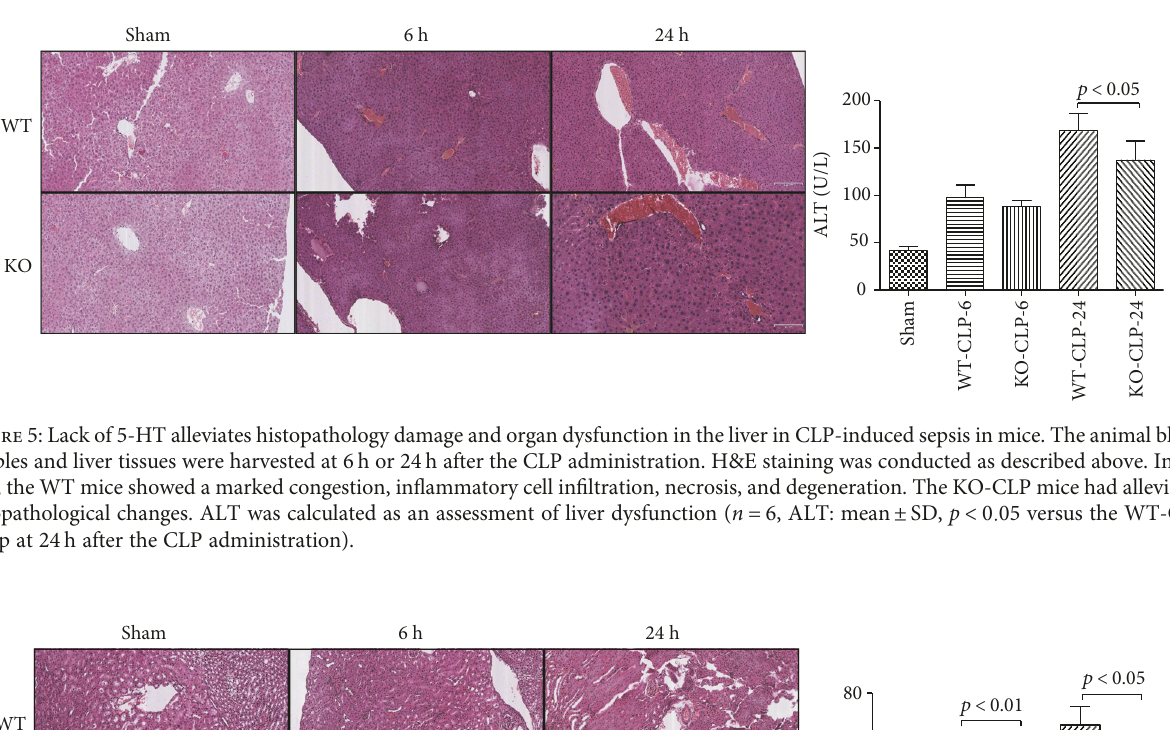
Figure 4: Lack of 5-HT alleviates histopathology damage and organ dysfunction in the lung in CLP-induced sepsis in mice. The lung tissues were harvested at 6h or 24h after the CLP administration. The lung tissue sections were stained with H&E. Original magni fi cation 200x. In the lung, the in fl ammatory in fi ltration of neutrophils, macrophages, and plasma cells in the WT-CLP sepsis group was more serious than in the KO-CLP sepsis group. The fi gures are representative of at least three experiments performed on di ff erent experimental days. The lung wet/dry weight ratio was calculated as an assessment of lung dysfunction ( n = 6 , lung wet/dry weight ratios: calculated by dividing the wet weight by the dry weight. Mean ± SD, p < 0 05 versus the WT-CLP group at 6 after the CLP administration).